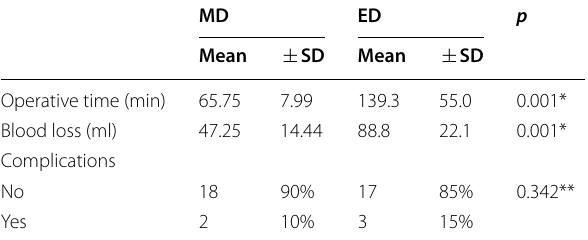
Table 6 Comparison between the 2 study groups regarding the operative time, intraoperative blood loss and incidence of operative complications